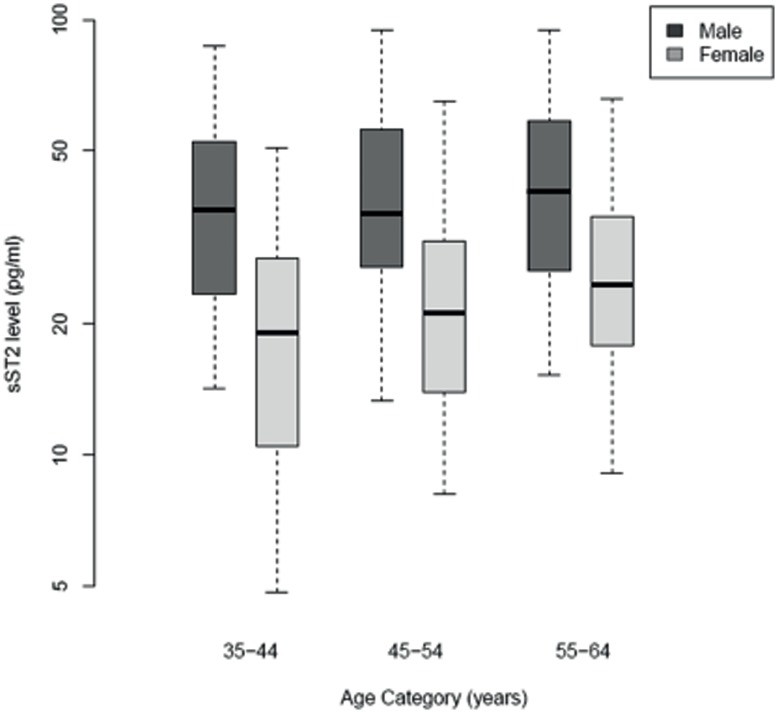
sST2 levels (pg/ml) by gender and age.Each box represents the median and upper/lower quartiles with the whiskers showing the 5th and 95th percentiles.